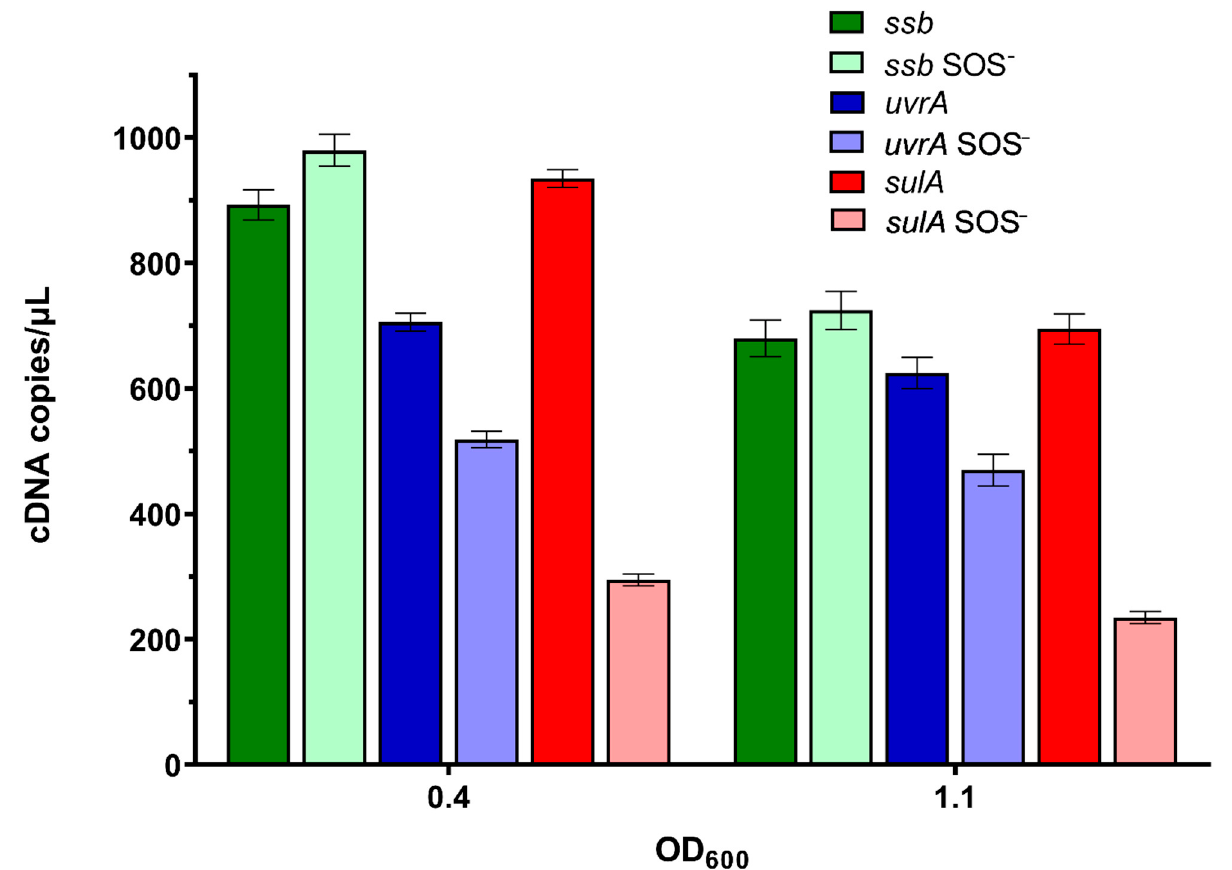
Figure 5. Absolute quantification of the ssb , uvrA, and sulA genes’ transcripts during growth of wild-type and lexA3 (SOS − ) mutant bacteria in LB medium at 37 ◦ C. Measurements were taken at mid-exponential growth phase (OD 600 ~0.4) and early stationary growth phase (OD 600 ~1.1). Three independent ddPCR experiments at three different concentrations gave the same relative results (the presented results are with 24 ng cDNA/sample). Error bars represent Poisson confidence interval at a 95% level.